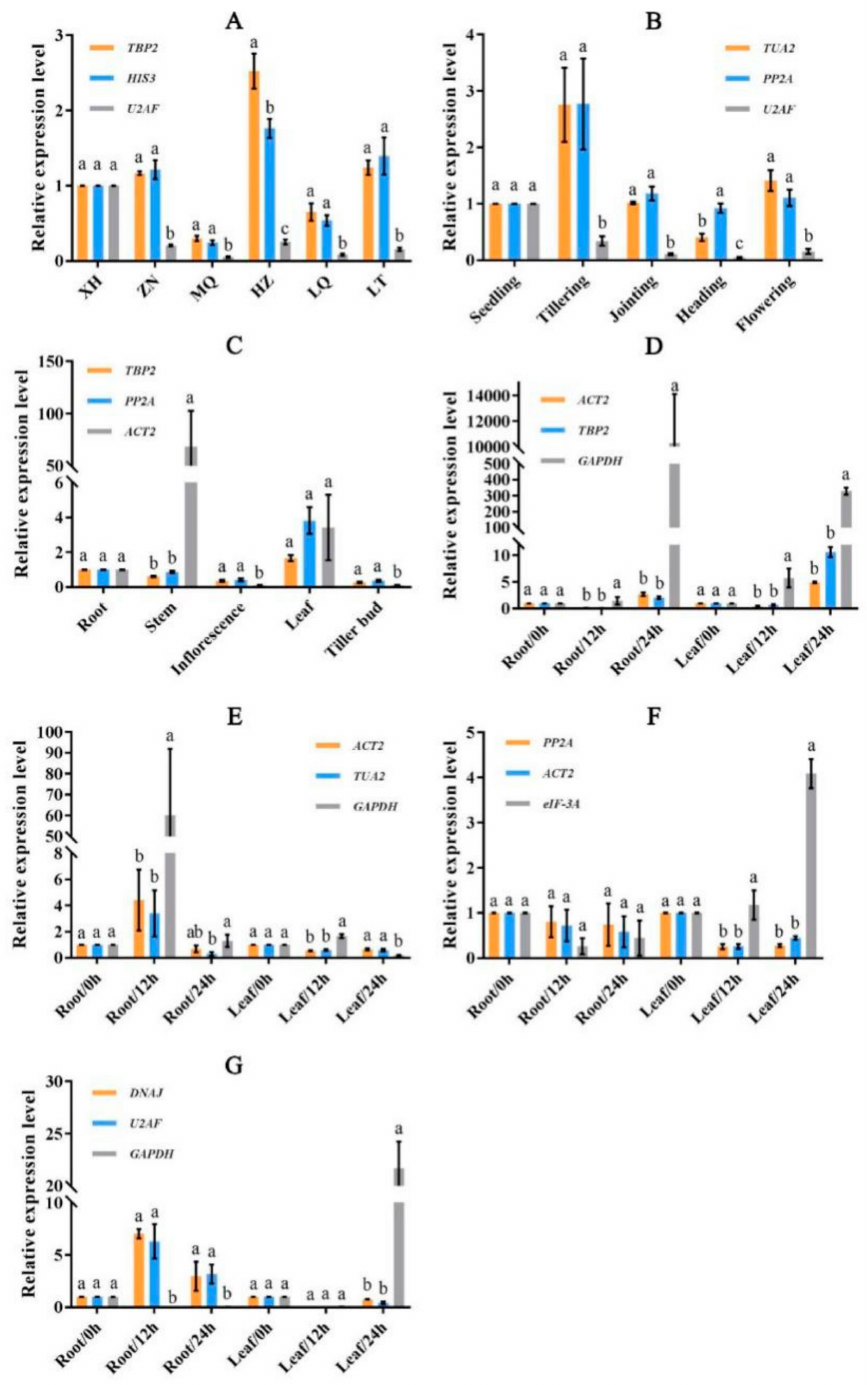
Figure 8. The relative expression level of target gene CSLE6 in various experimental conditions. The most two stable reference genes and the most unstable reference genes in di ff erent conditions were selected for expression normalization. ( A ) Di ff erent genotypes, ( B ) di ff erent developmental stages, ( C ) di ff erent tissues, ( D ) salt stress, ( E ) heat stress, ( F ) cold stress, and ( G ) osmotic stress. Di ff erent letters in the same sample represent a significant di ff erence among three reference genes at the 0.05 level. Error bars indicate standard